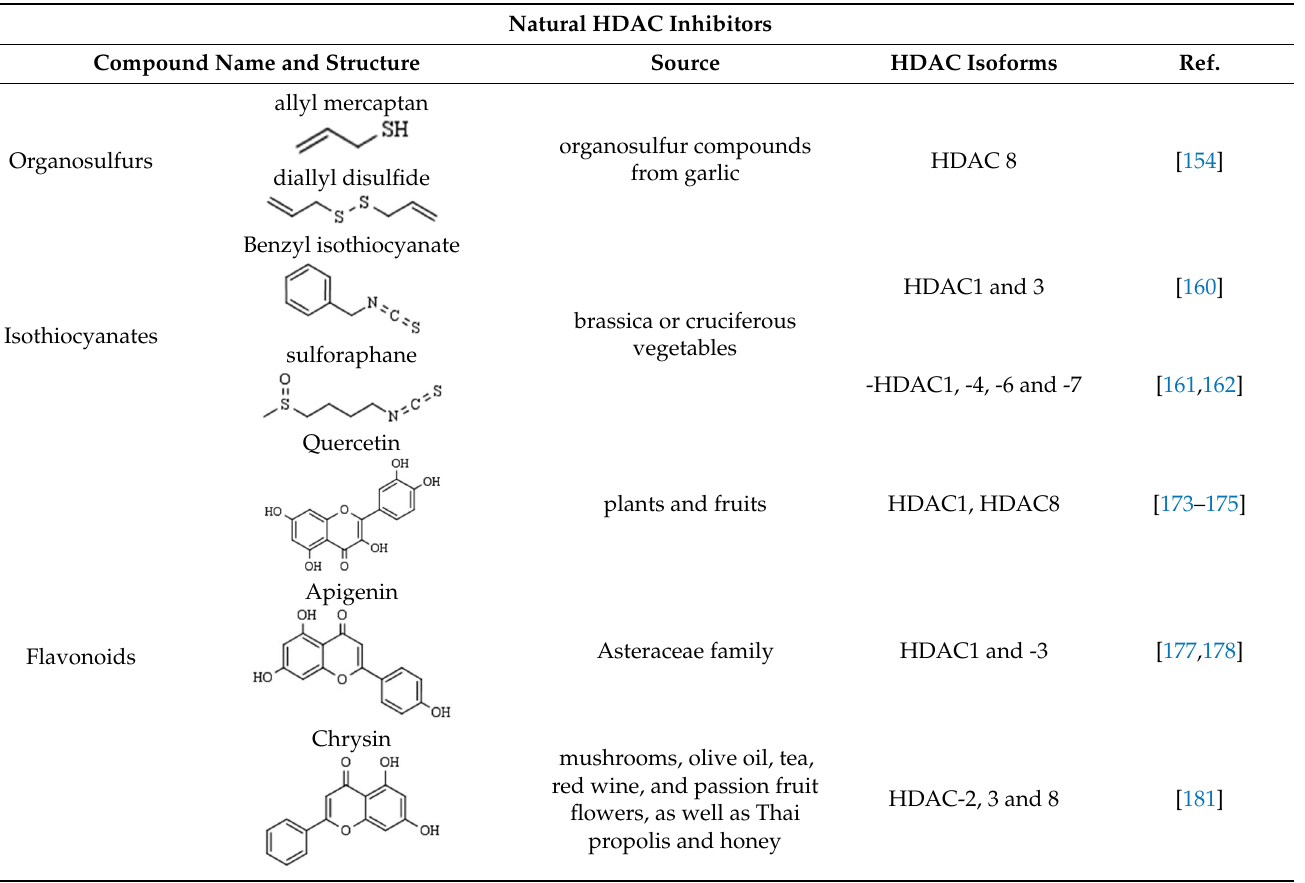
Table 3. Inhibition of HDAC activity by selected natural products in cancer cells. Natural HDAC Inhibitors